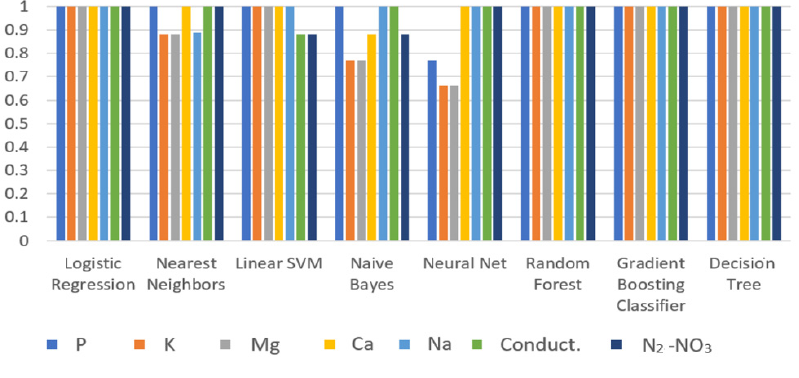
Figure 18. Train Figure 18. Train score.